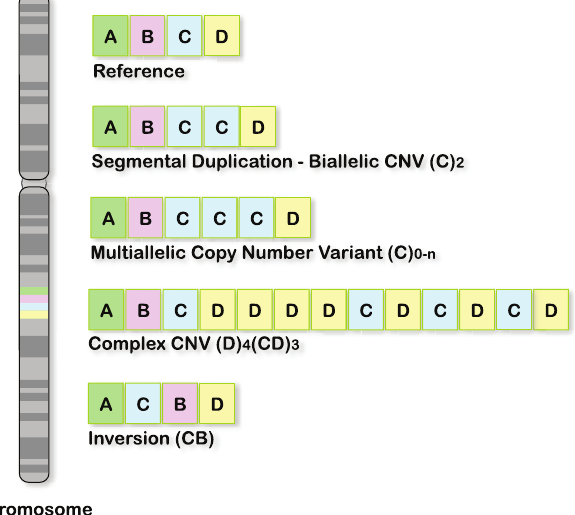
Figure 1. Types of Genomic Structural Changes Affecting Segments of DNA, Leading to Deletions, Duplications, Inversions, and CNV Changes (Biallelic, Multillelic, and Complex) The only segment that is constant is ‘‘ A. ’’ Segment ‘‘ B ’’ varies in orientation in the inversion. Segments ‘‘ C ’’ and ‘‘ D ’’ show different types of